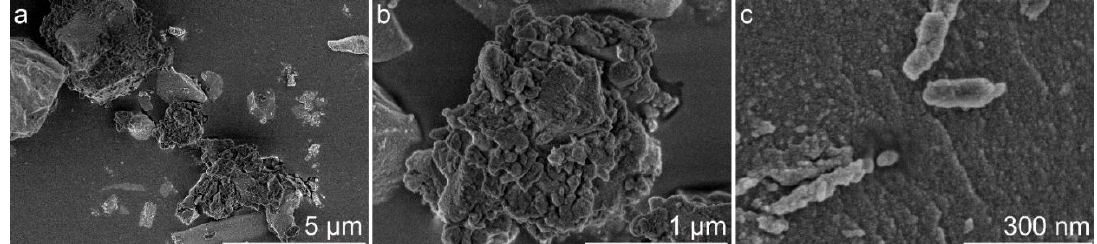
( b , e ) ×50,000, ( c , f ) ×150,000).